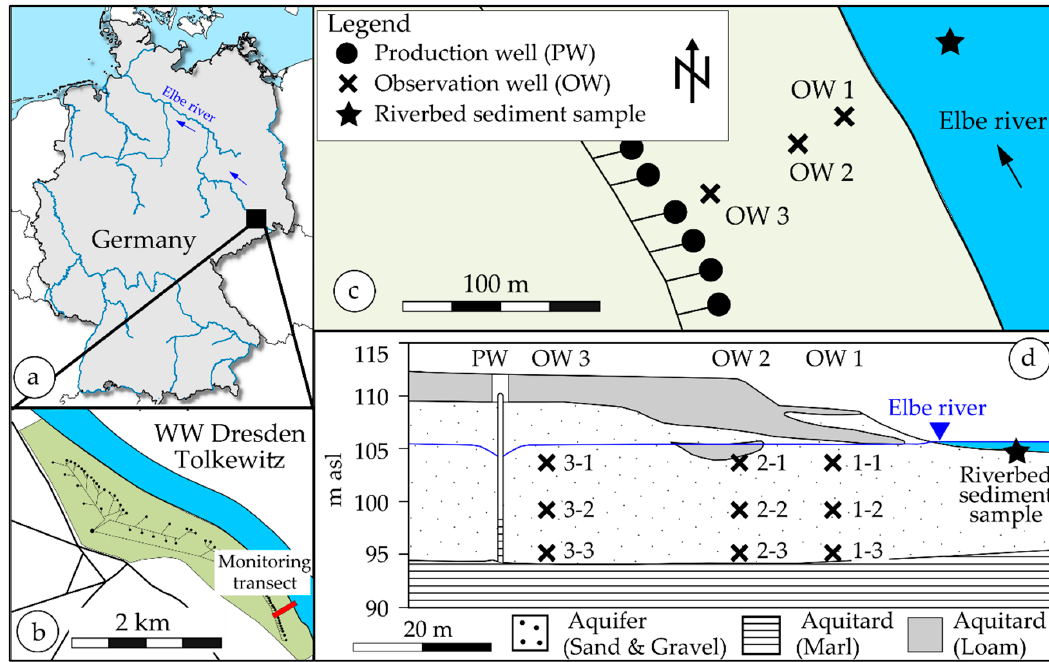
Figure 1. ( a ) The location of the RBF Waterworks Dresden-Tolkewitz, ( b ) Observed transect between the Elbe river and the pumping well (PW), ( c ) Location of the observation wells within the transect and sampling point of the riverbed sediment for the column experiment, ( d ) cross-section of the transect and locations of the observation points for each observation well (OW).